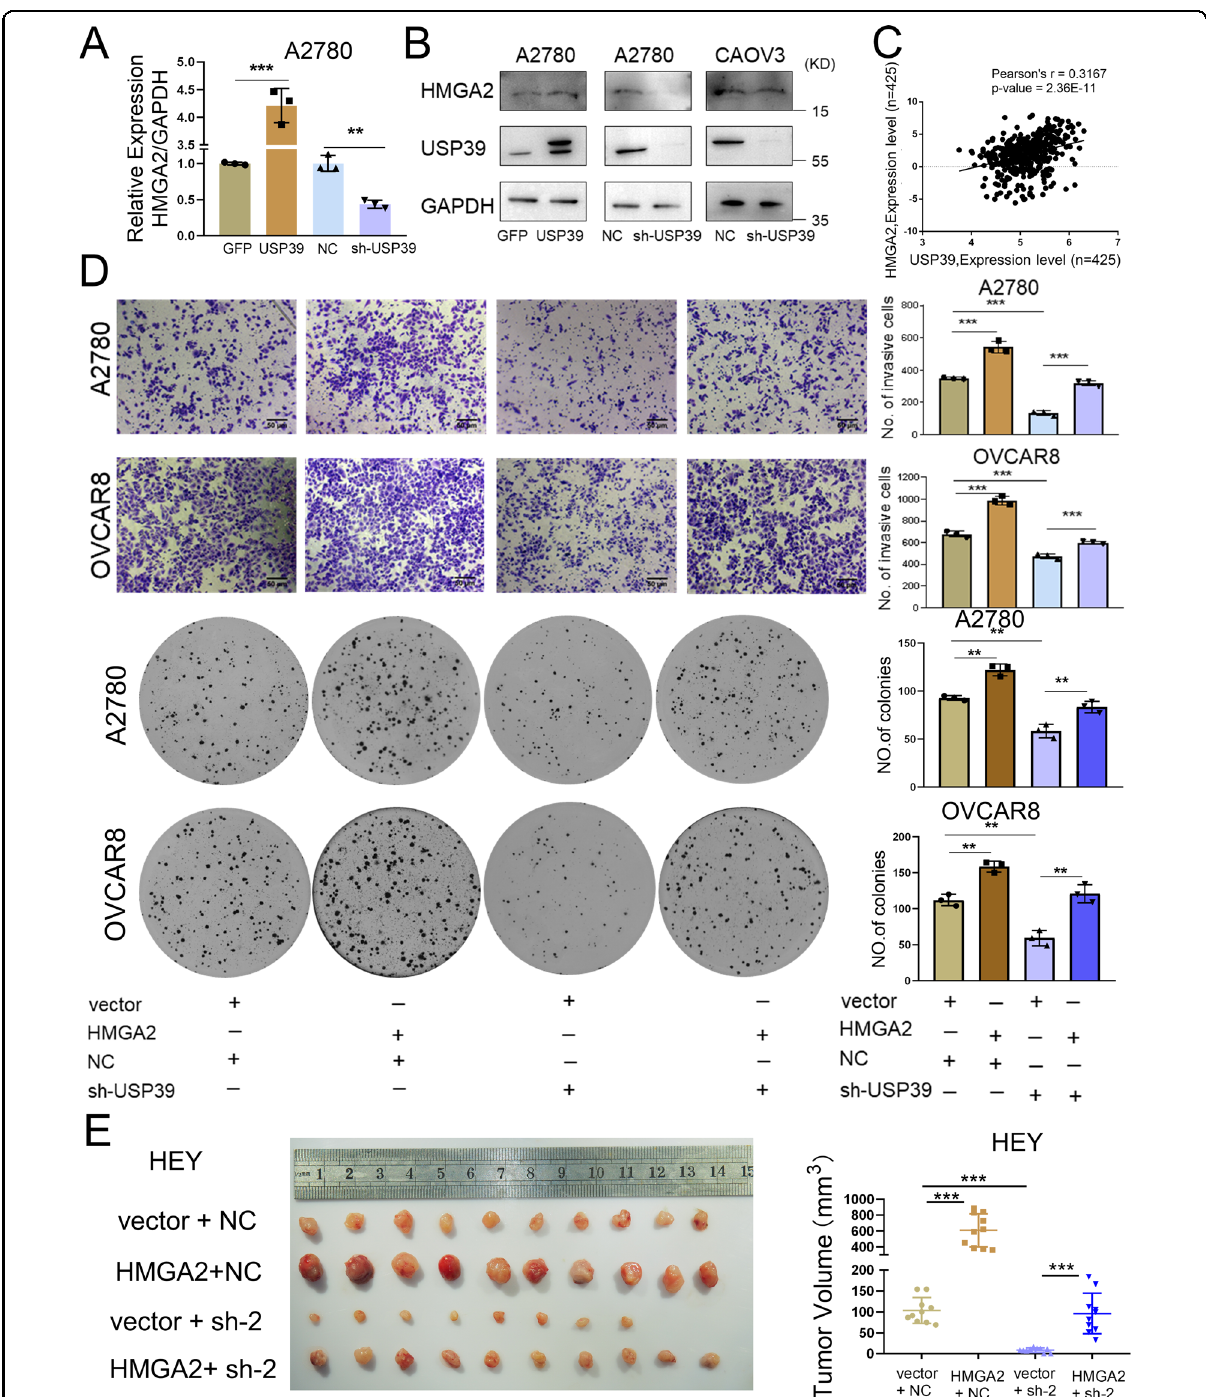
Fig. 8 USP39 promotes tumor progression by increasing HMGA2 levels in ovarian cancer cells. A Relative HMGA2 mRNA expression as measured by qPCR in A2780 cells with USP39 overexpression (USP39) or knockdown (sh-USP39) compared to corresponding control ( n = 3 biologically independent samples). B Immunoblot analysis of HMGA2 and USP39 protein levels in ovarian cancer cells with USP39 overexpression or knockdown. C Pearson correlation analysis of USP39 and HMGA2 expression in HGSOCs from the TCGA cohort. D Transwell and clonogenic assays for investigating the potential of HMGA2 to rescue the loss of USP39 in ovarian cancer cells as indicated ( n = 3 biologically independent samples). E Xenograft experiments showed HMGA2 could rescue the loss of USP39 in tumor growth in vivo ( n = 10 mice per group). P value was obtained by Student ’ s t -test and ANOVA analysis. Results represent the mean ± SD of three independent experiments. * P < 0.05, ** P < 0.01, *** P <